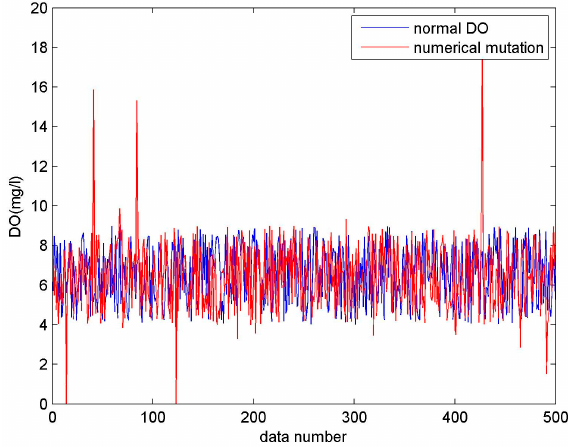
Figure 6. Numerical mutation (DO).